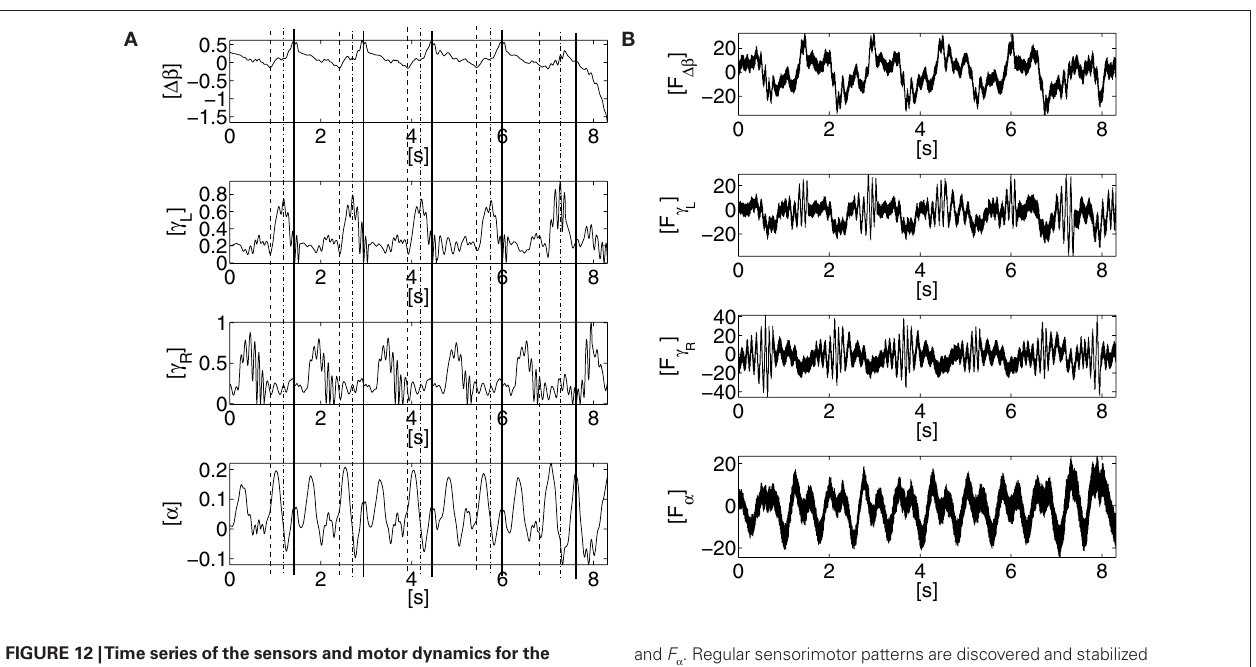
FIGURE 12 | Time series of the sensors and motor dynamics for the and F α . Regular sensorimotor patterns are discovered and stabilized parameters { ε , ε , G } ∈ [0; 1] × [0; 1] × [10]. (A) time series of the dynamically in the whole system, i.e., partial and dynamic phase 1 2 joint angles of the hip Δβ , of the knees γ , of the torso alpha , and their synchronization (see the dashed and plain lines in (A) ) – till one perturbation { L , R } respective torque command activation in (B) resp. F Δβ , F γ , destroys the { L , R }